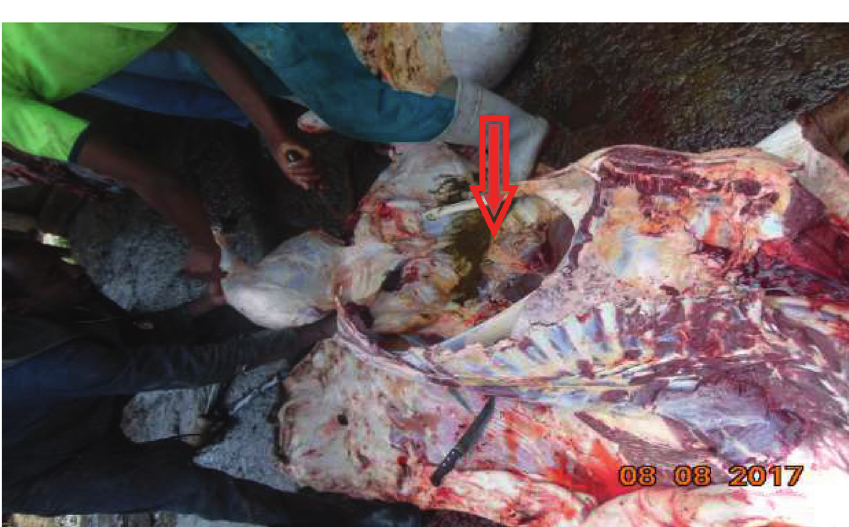
Figure 1: Contamination of carcass by visceral content at Ambo municipal